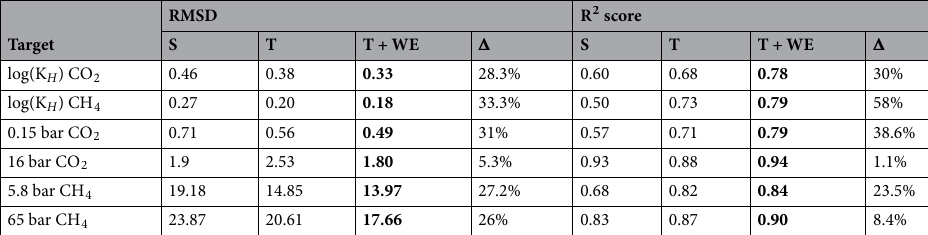
Table 2. Model performance on BW dataset. Root-mean-square-deviation (RMSD) and coefficient of determination (R 2 score) results in predicting the Henry’s coefficient (log k H ) for CO 2 and CH 4 , gas uptakes for CO 2 , and gas uptakes for CH 4 for the BW dataset. Different sets of features (S = baseline structural, T = topological, T + WE = topological and word embeddings) are shown. For each target, the units are mol kg − 1 Pa and V STP /V respectively. The best model is in bold. As the improvement from the topology + word embeddings is always greater than the structural features, the percentage of improvement (decrease in the case of RMSD and increase in the case of R 2 score) is also shown ( (cid:31)